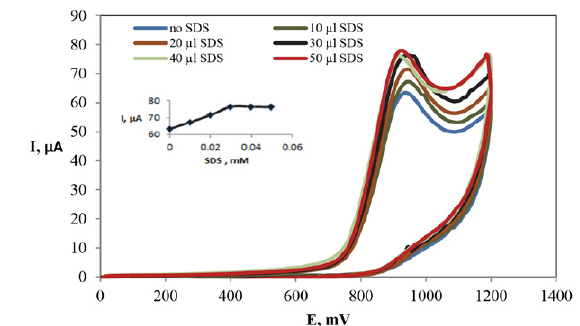
Figure 6. Cyclic voltammograms recorded in 1.0 mM SLC con- taining different concentrations of SDS, the measurements were carried out using 40% sephadex carbon paste electrode in BR buff- er pH 7.0.